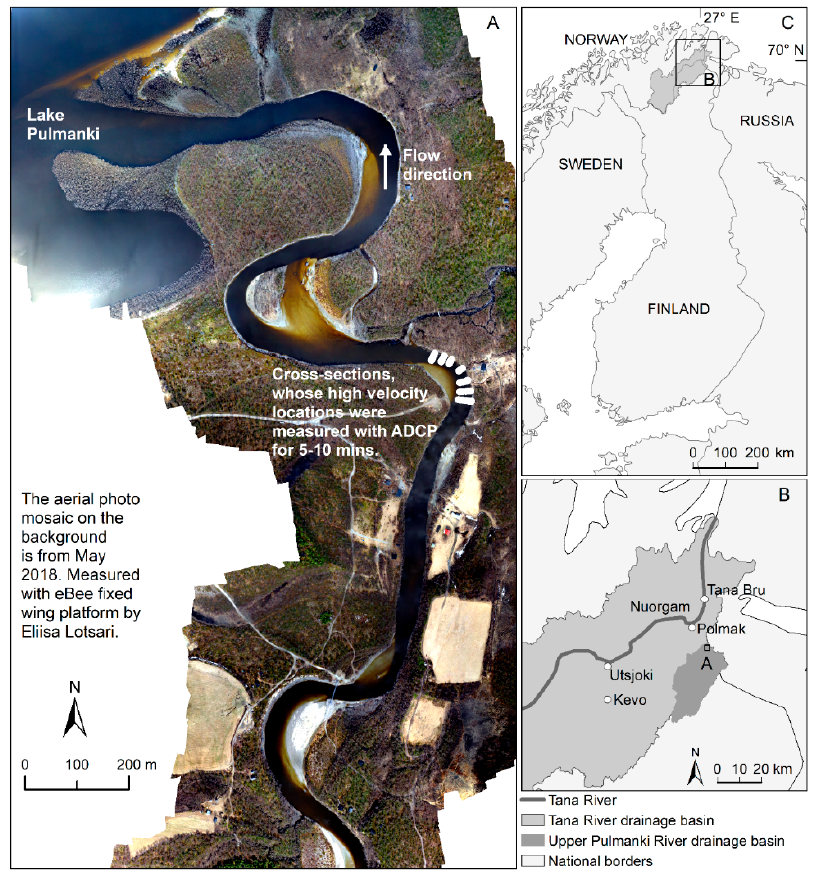
Figure 1. Theoverallstudysitelocation. ( A )Aerialphotographofthestudysitelocation. Themeasurements Figure 1. The overall study site location. ( A ) Aerial photograph of the study site location. The were done from the high velocity core location of seven cross-sections. ( B , C ) The location of the study site measurements were done from the high velocity core location of seven cross-sections. ( B ) and ( C ) The in location of the study site in Finland.